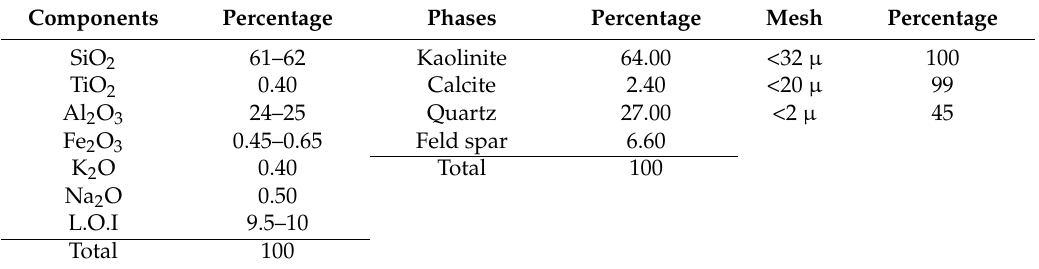
Table 1. The analysis of the Kaolin